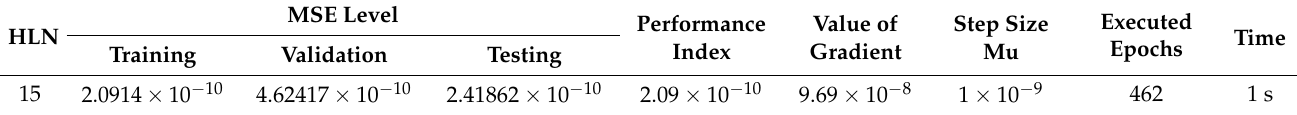
Table 4. ANNLMB outcomes of Scenario 2 for heat transfer in spinning nanofluid.